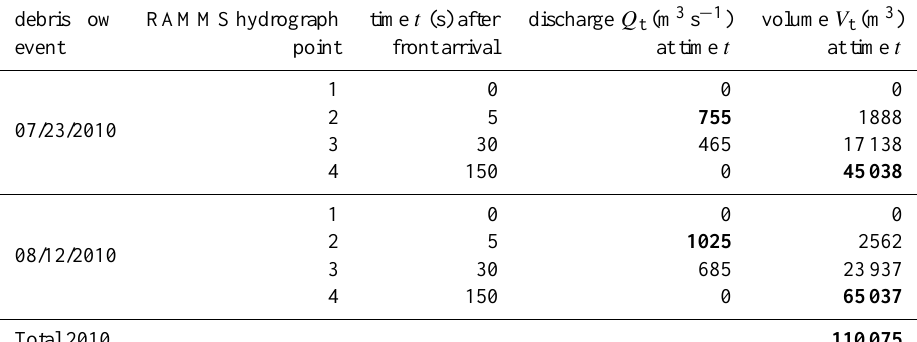
Table 3. The two largest debris flow events from 2010 are described by a two-surge input hydrograph used for the runout erosion model testing. Peak discharge Q p (bold) is derived from debris flow event volumes V (bold) based on Eq.